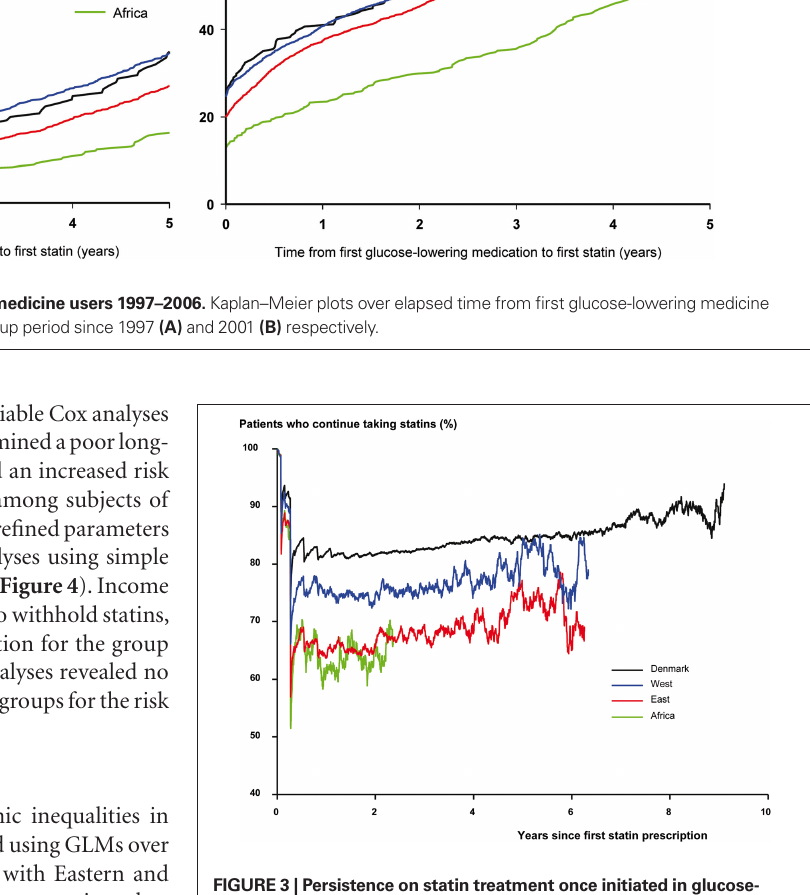
FiguRe 3 | Persistence on statin treatment once initiated in glucose- lowering medicine users. Proportion of patients receiving glucose-lowering medication who were taking statins at any time-point after initiation of statin treatment stratified by ethnic origin. Curves end when less than 50 persons continue